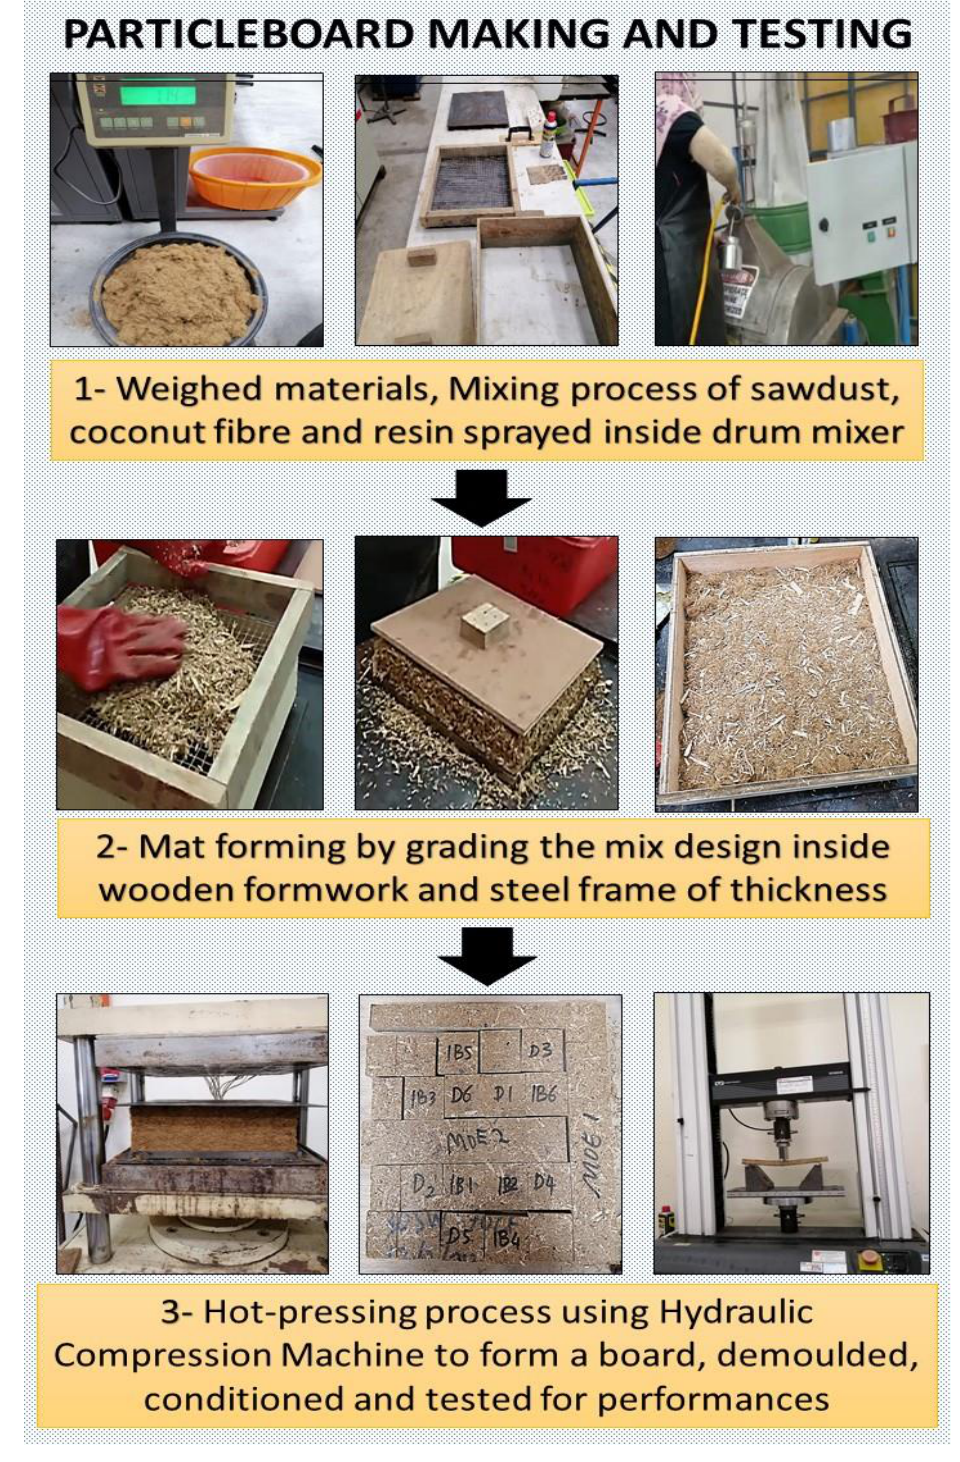
Figure 3. Particleboard Making Process and Testing .